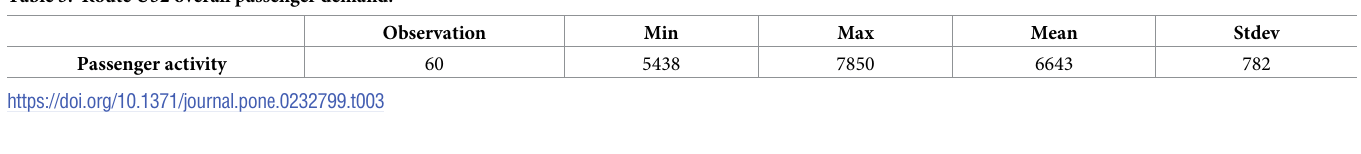
Table 3. Route U32 overall passenger